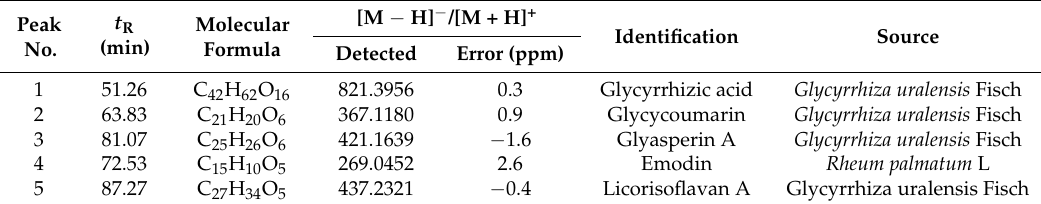
Table 1. The identification of compounds from active components.